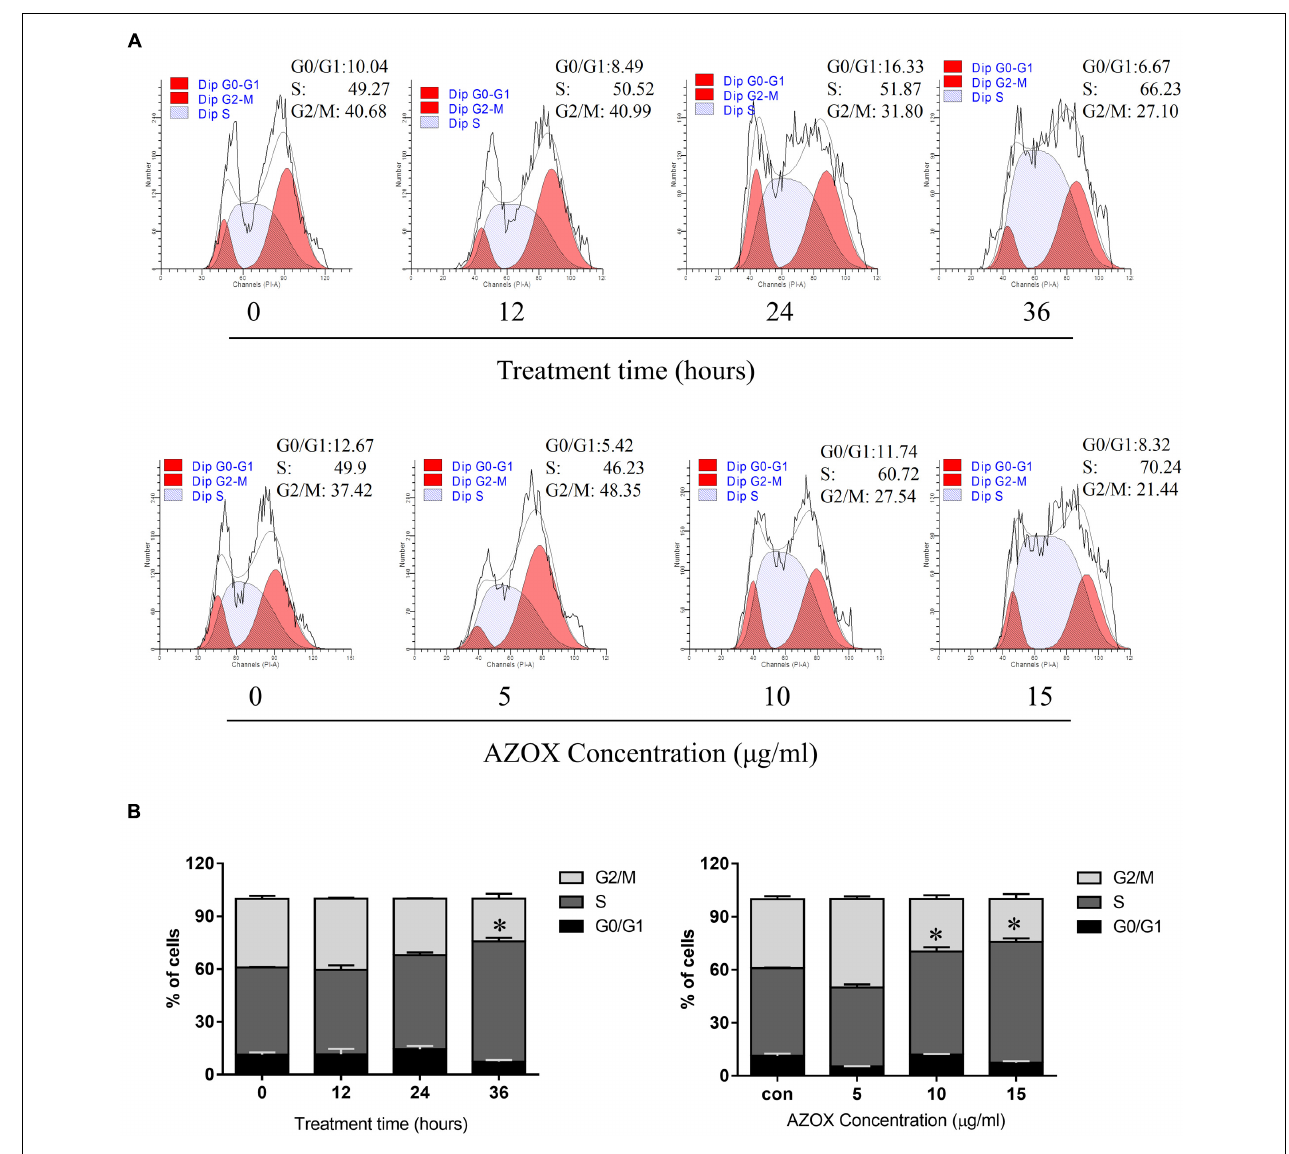
FIGURE 2 | AZOX induced KYSE-150 cell cycle arrest. (A) Cells were treated with AZOX (15 µ g/ml) time-dependently and then with indicated doses of AZOX for 36 h. Flow cytometry cell cycle analysis of KYSE-150 cell cycle arrest with AZOX treatment for different concentration or different time point were then performed. (B) Statistical charts of G0/G1, S and G2/M phase. All data are represented as means ± SEM of three independent experiments ( ∗ p <